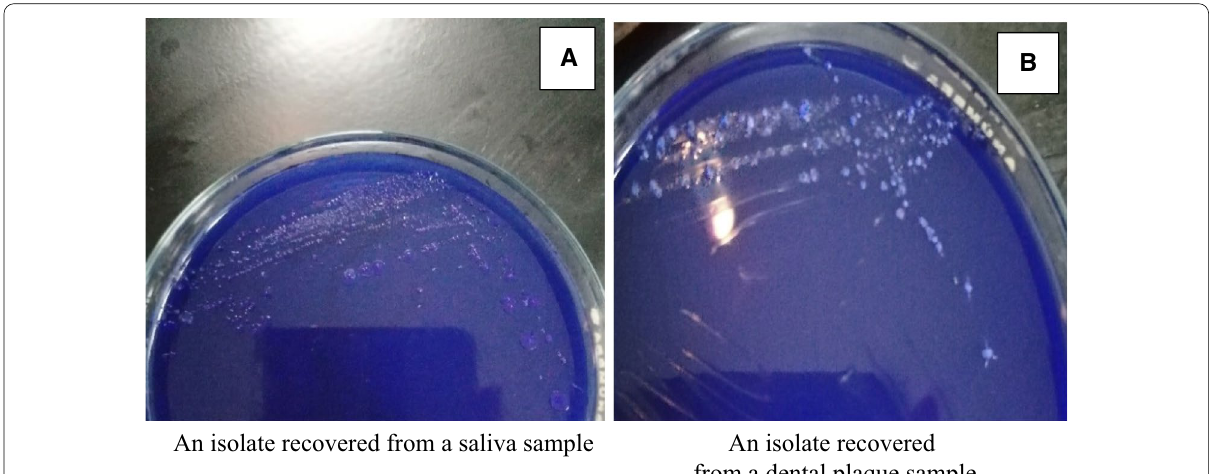
Fig. 1 Colonies’ appearance of two representative isolates recovered from a saliva ( A ) and a dental plaque sample ( B ) on mitis salivarius medium